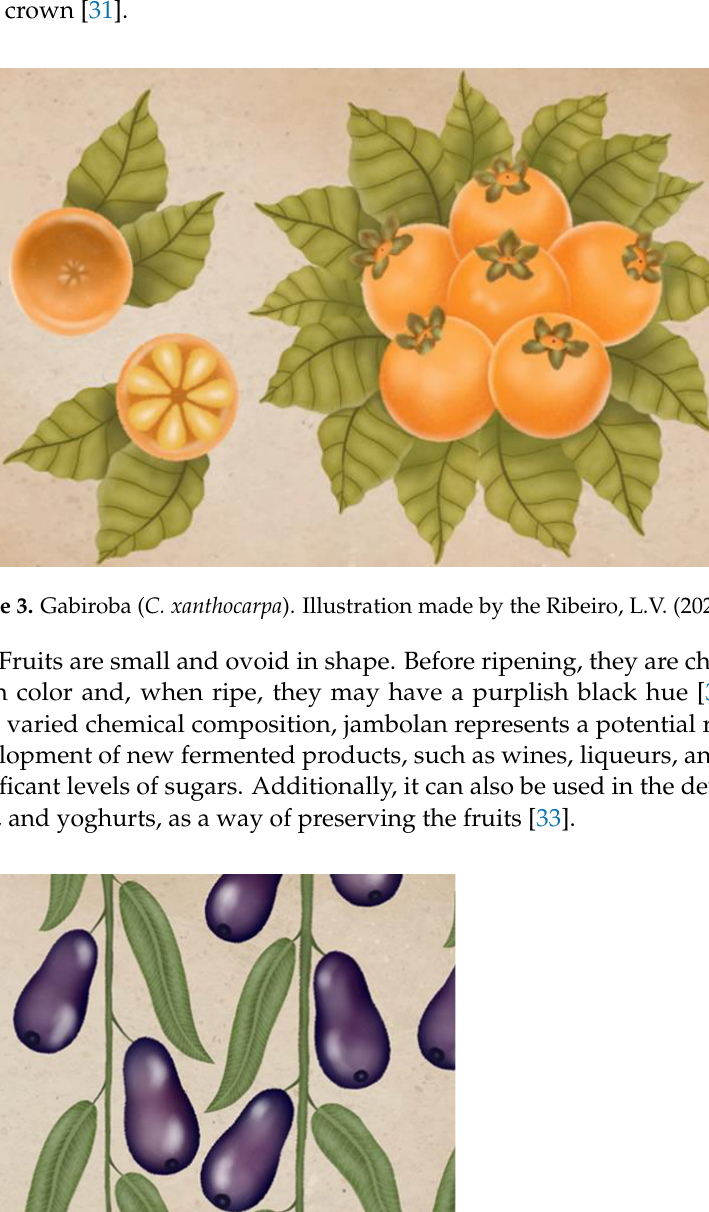
Figure 3. Gabiroba ( C. xanthocarpa ). Illustration made by the Ribeiro, L.V. (2022).